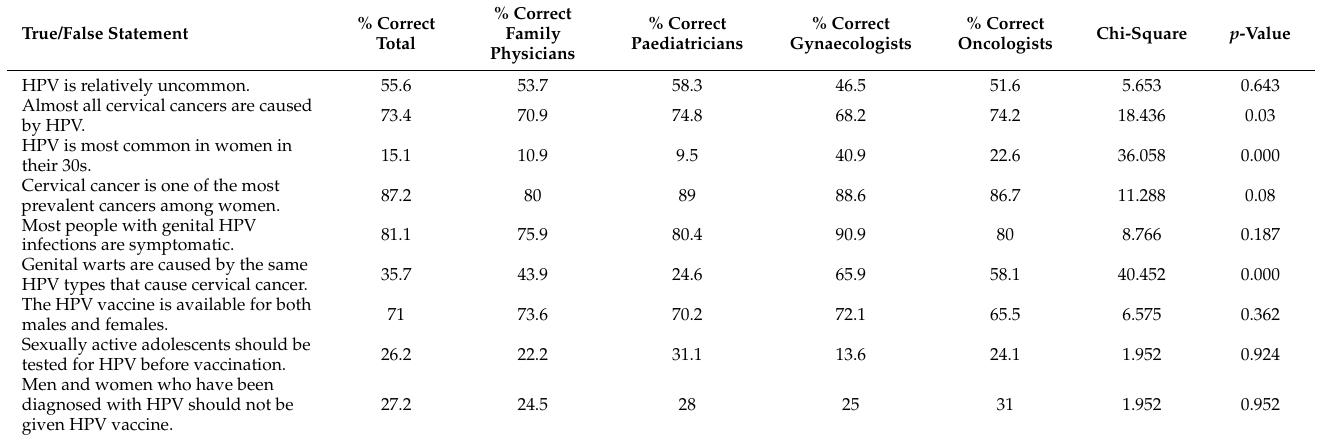
Table 2. Knowledge of HPV. Comparison between physicians practicing different specialist